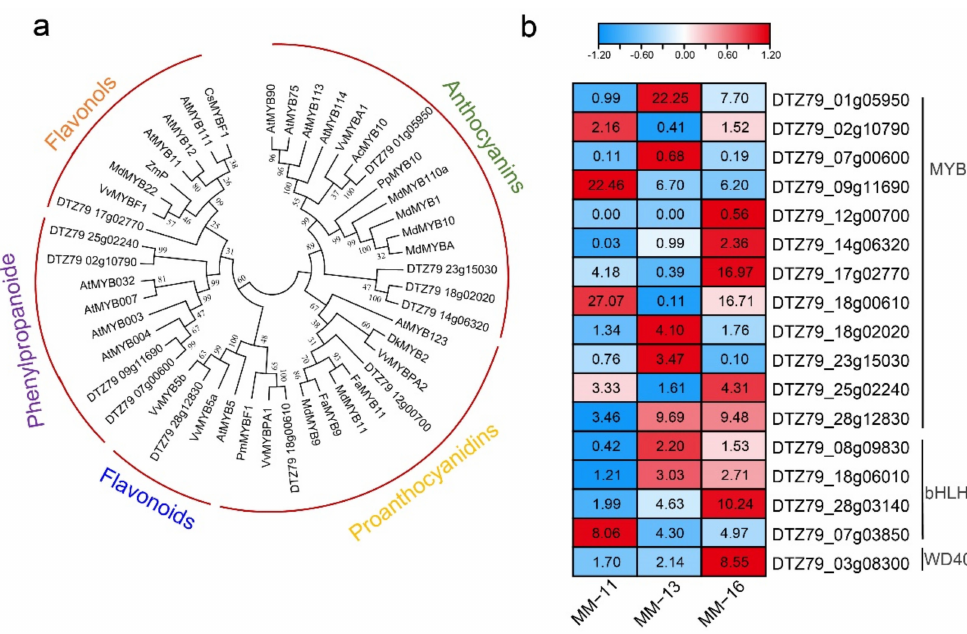
Figure 6. Transcription factors involved in phenolic acid, flavonoid and anthocyanin biosynthesis. ( a ) Phylogeny of MYBs in the anthocyanin, proanthocyanidin, phenylpropanoid, flavonols and flavonoids clades. ( b ) Heatmap of the MYB, bHLH and WD40 transcription factors